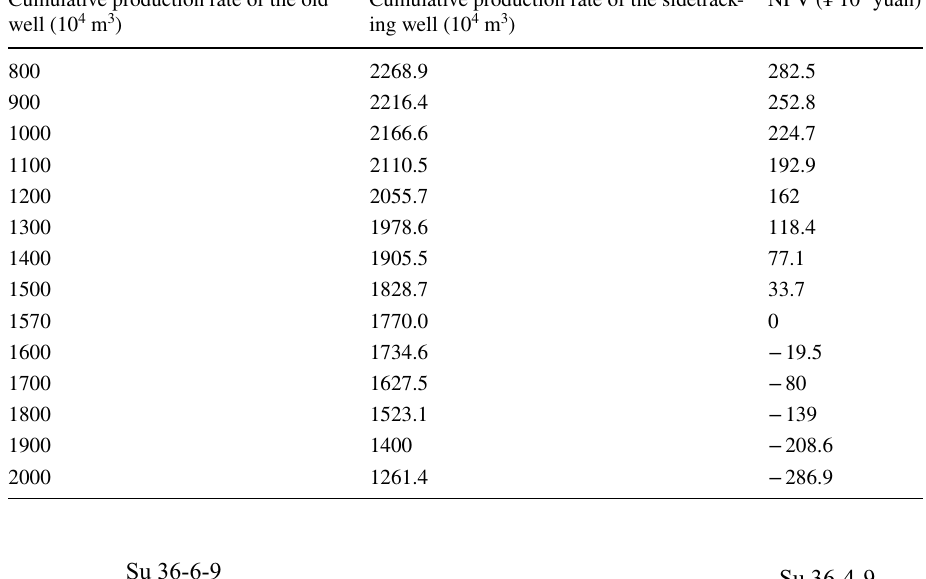
Fig. 10 Profile of well